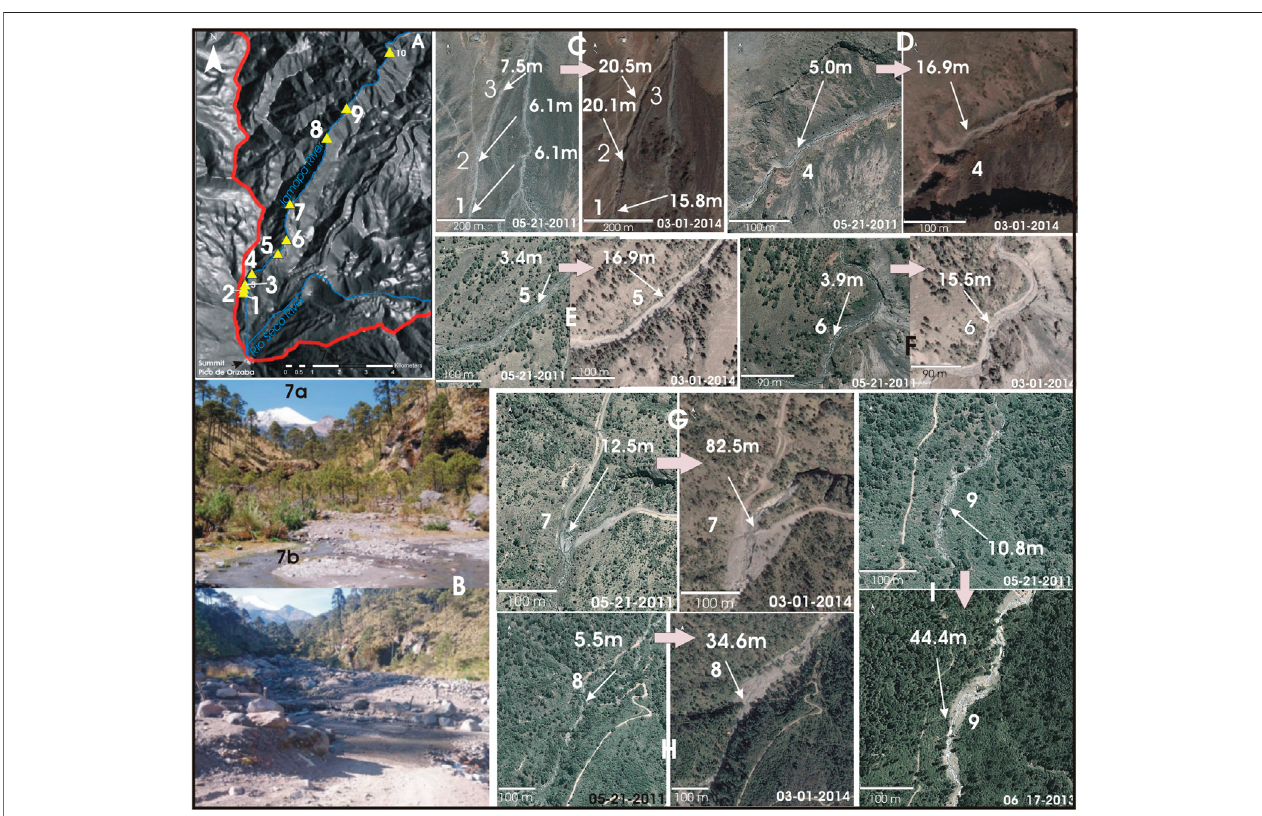
FIGURE 2 | (A) – overview of the upper Jamapa watershed (DEM) and virtual “ sample points ” (1 – 9) of visual channel width changes. (B) – location number 7 before (7a) and after (7b) the 2012 lahar event. (C – I) Satellite image analysis before and after the 2012 lahar event [location numbers correspond to the ones in (A) ]. Measured before- and after widths are